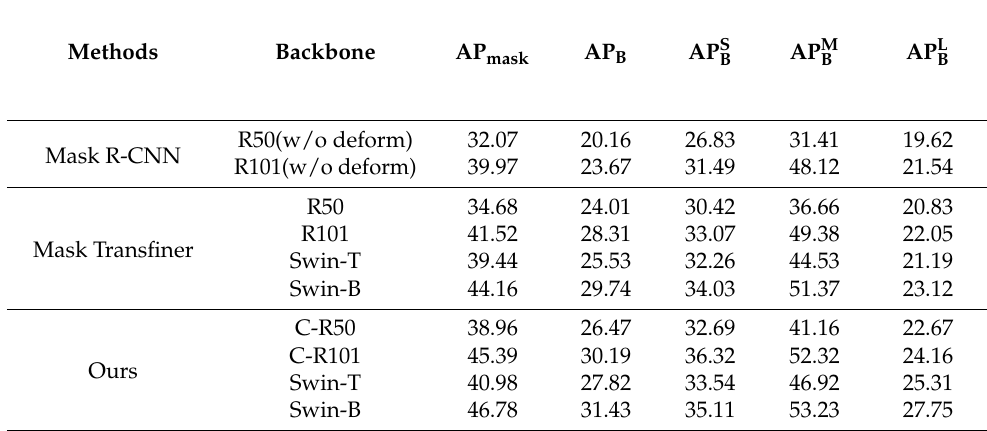
Table 6. Comparison performance of different models on AP B